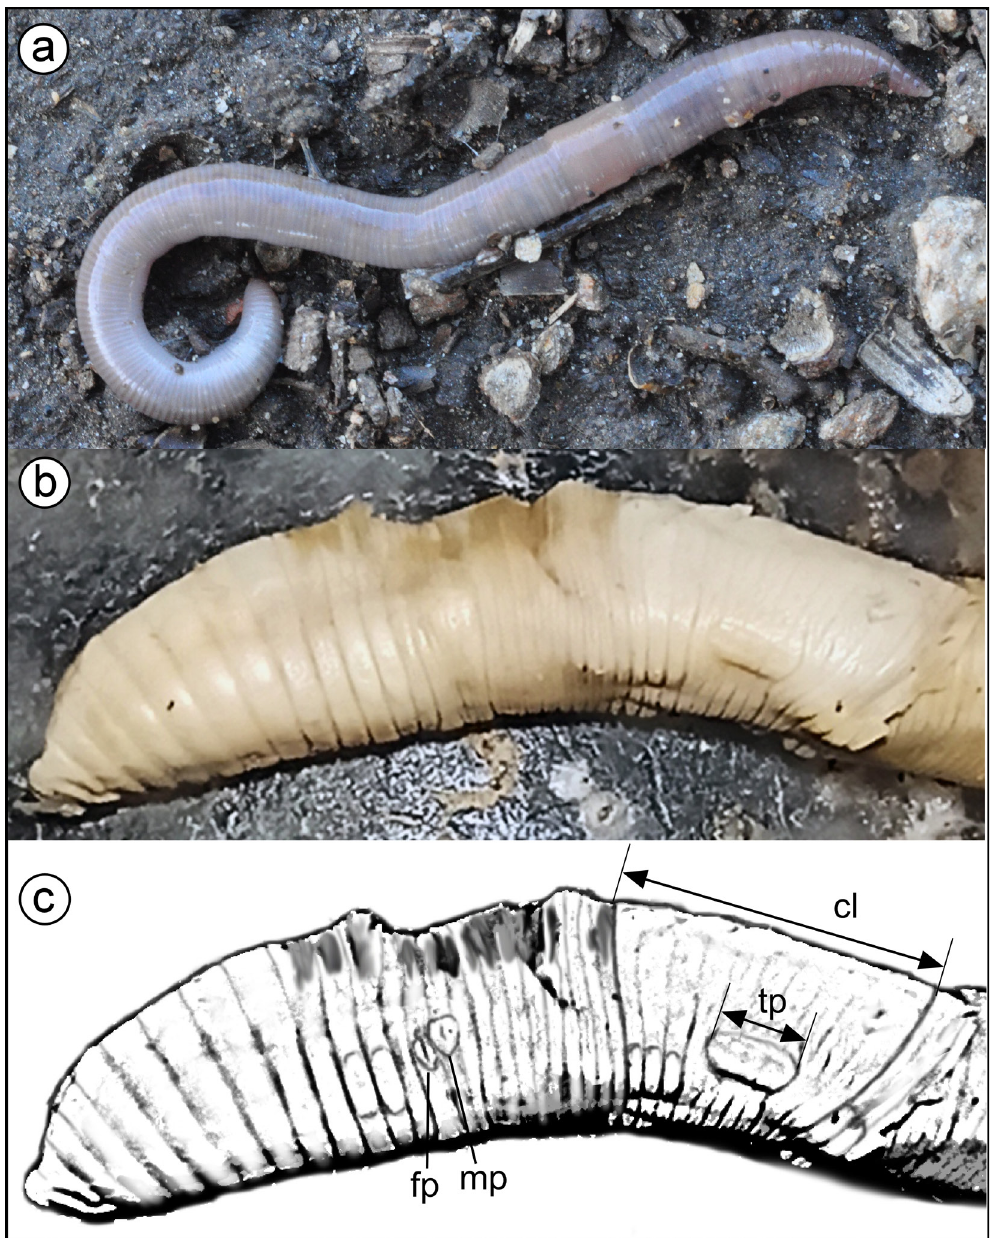
Fig. 3. External morphology of Scherotheca portcrosana Marchán & Decäens sp. nov. a . Live specimen (© T. Decaëns). b . Fixed specimen. c . Schematic drawing. Abbreviations: cl = clitellum; fp = female pore; mp = male pore; tp = tubercula